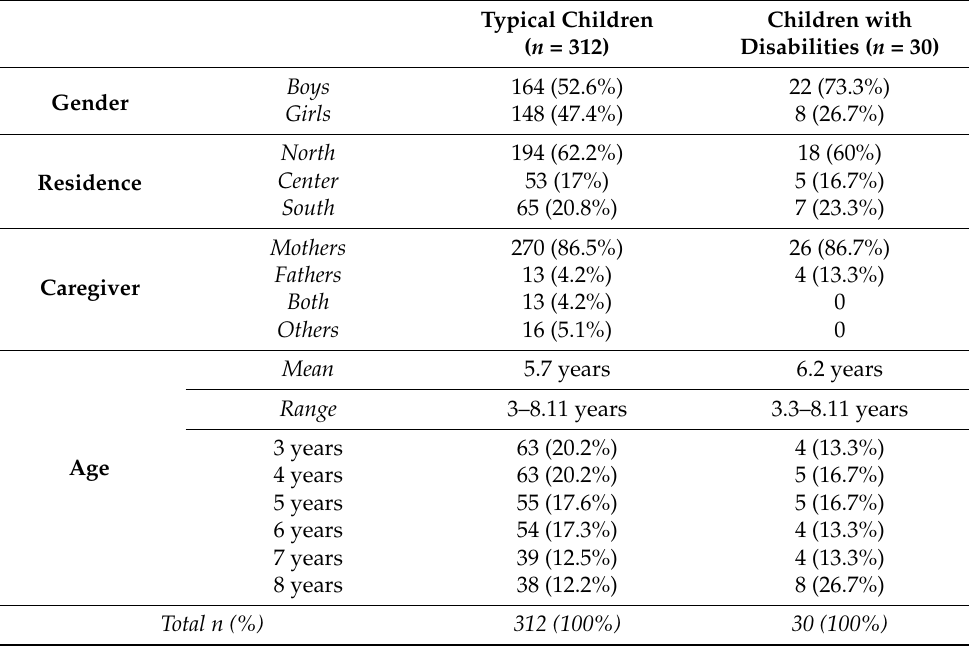
Table 2. Socio-demographic information of the participants.